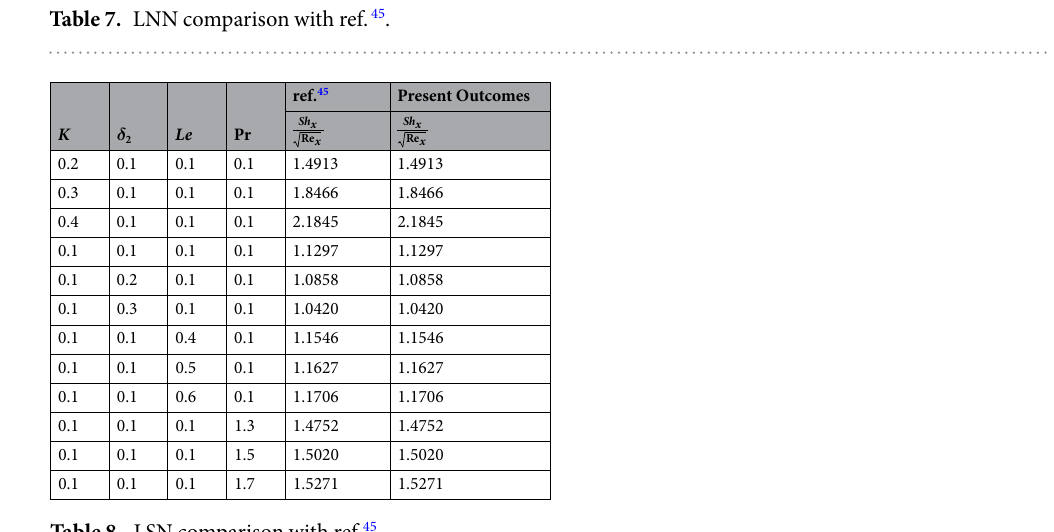
Table 8. LSN comparison with ref. 45